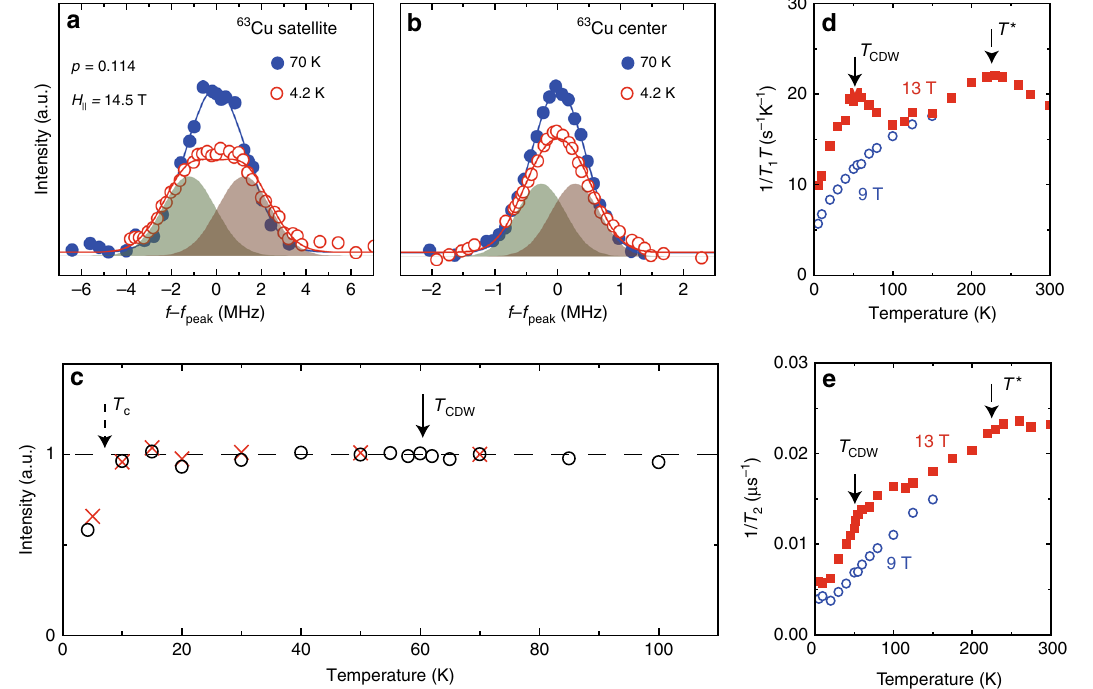
Fig. 2 Evidence for the CDW without a spin order. Temperature dependence of the NMR satellite a and center b lines for p = 0.114 at H = 14.5 T. Solid curves are the results of Gaussian fi ttings. The curves at T = 4.2 K are the sum of two Gaussian functions (shaded area). c Temperature dependence of NMR signal intensity for the satellite line (open circles) and the center line (crosses). The intensity is corrected by taking into account the 1/ T factor and the T 2 effect. The absence of any intensity loss across T CDW rules out the presence of any kinds of spin order. The intensity loss below T c is due to the Meissner effect. The temperature dependencies of 1/ T 1 T d and 1/ T 2 e at different fi